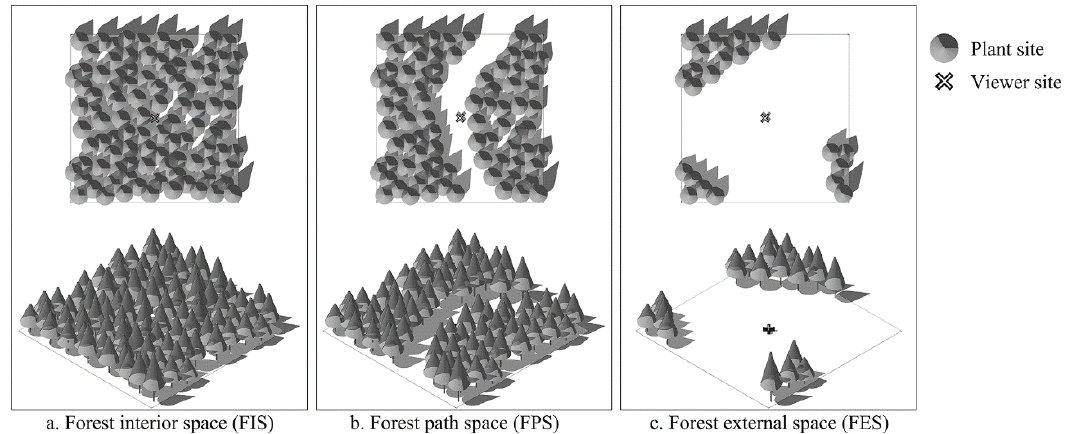
Figure 1. Three types of pure forest space based on scale.